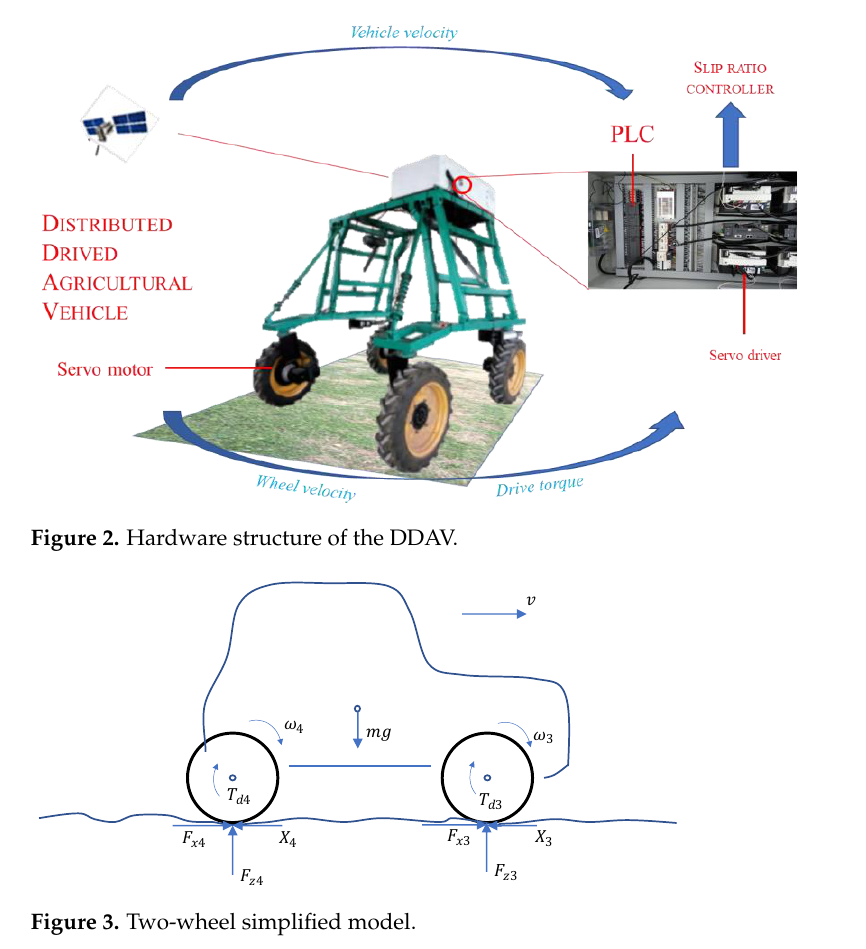
Figure 3. Two-wheel simplified model.